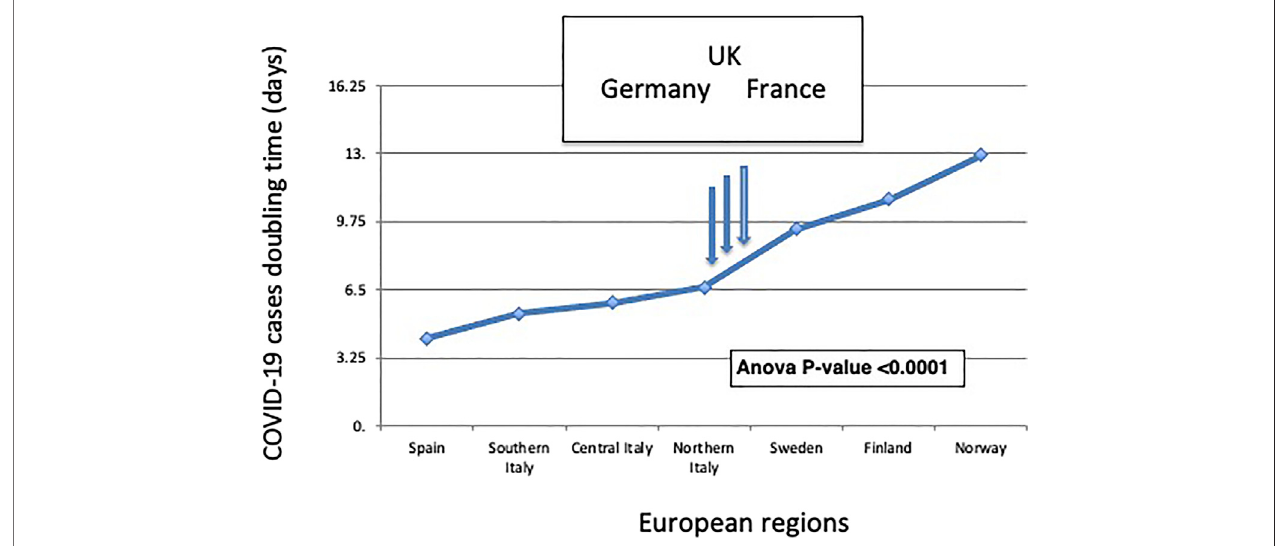
FIGURE4| TheNorth-South gradientofCOVID-19. Thedoubling time ofCOVID-19casesaccordingtodistinctgeographicareas isshown. European regions are listed from left to right according to their classi fi cation by climate zone ( Table 1 ). The ANOVA p -value for the association of the plotted values to climate zones is shown. The vertical arrows indicate the COVID-19 doubling times in the validation datasets of (from left to right) Germany, the United Kingdom, and